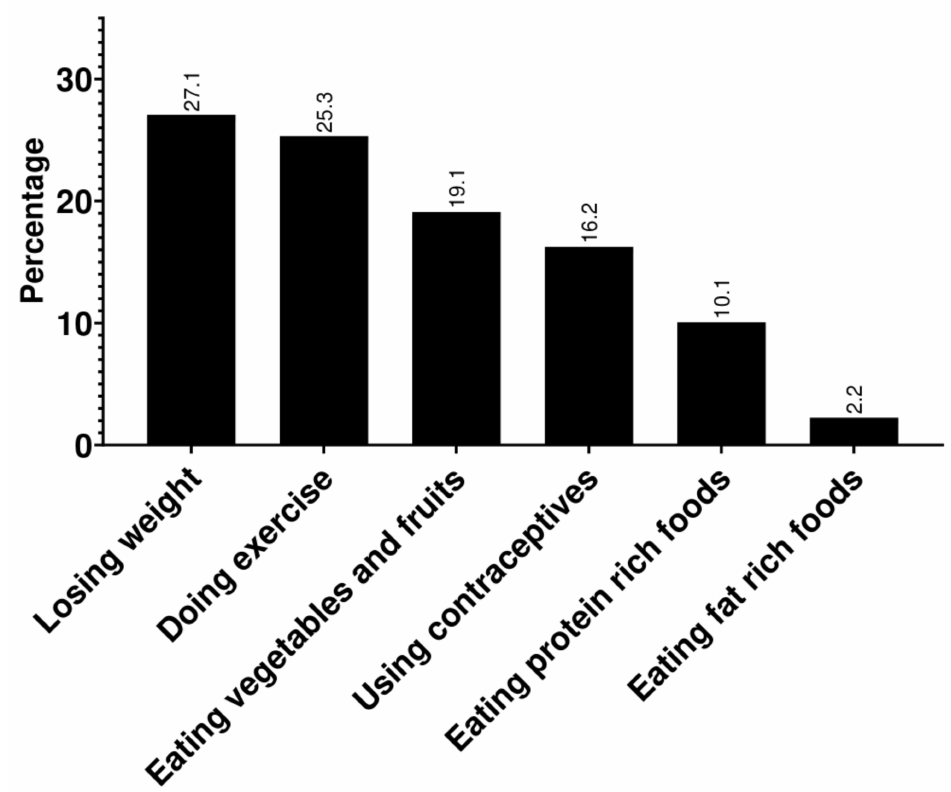
Figure 1. Knowledge of lifestyle modifications related to polycystic ovary syndrome symptoms